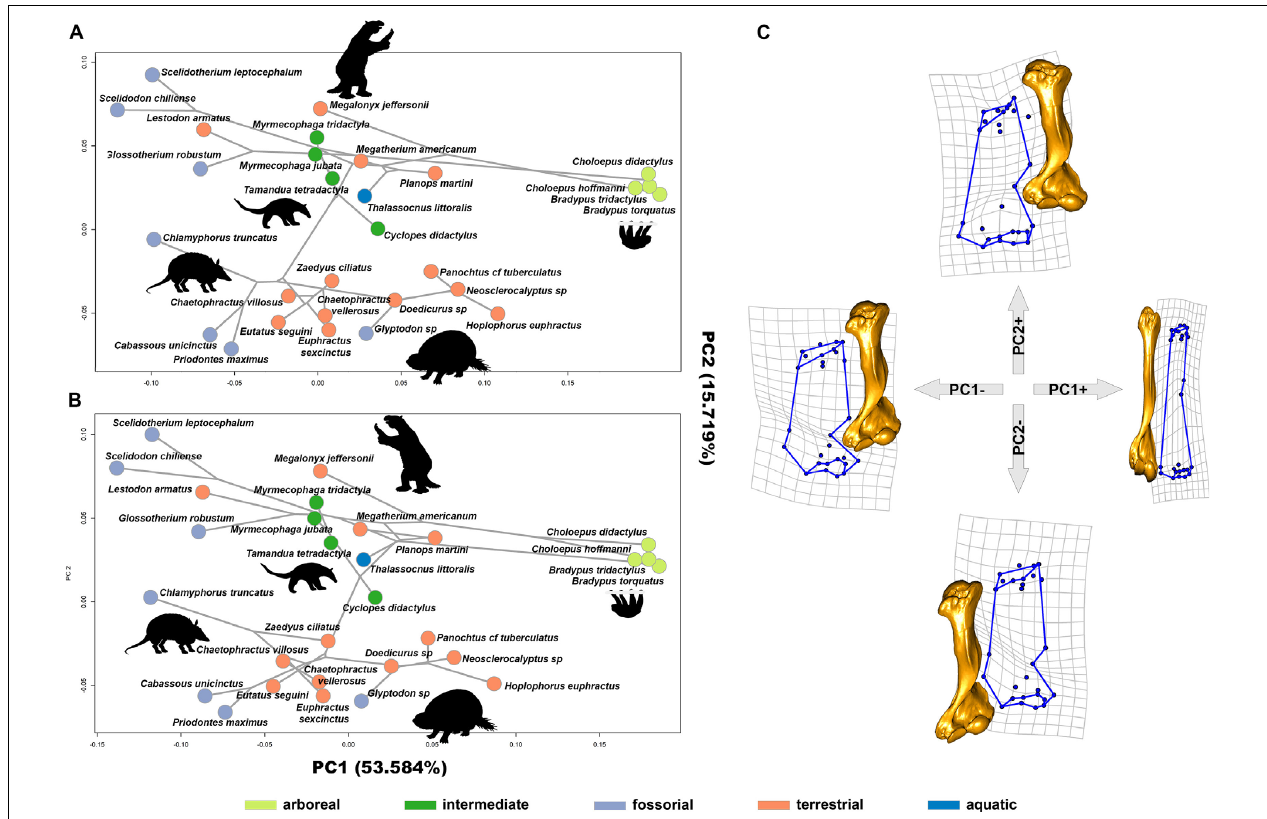
FIGURE 2 | Phylomorphospaces of PC1 vs. PC2 mapping molecular (A) and morphological tree (B) . Gray lines connect species with their reconstructed ancestral node. (C) Deformation grids and warping model (by using as reference T. littoralis ).